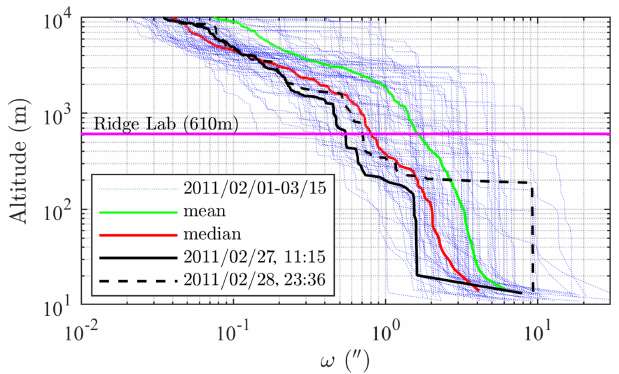
Figure 3. Vertical structure of starspot blurring at Eureka derived from the quadrature integration of Eq. (1). Most of the turbulence is below the Ridge Lab elevation (magenta line). The black curves were derived from the two nearest soundings to the ω measurements in Fig. 2. The k t = 6 (derived for the black curves) was employed for all the other curves. (Note that “ (cid:48)(cid:48) ” denotes arcseconds in this